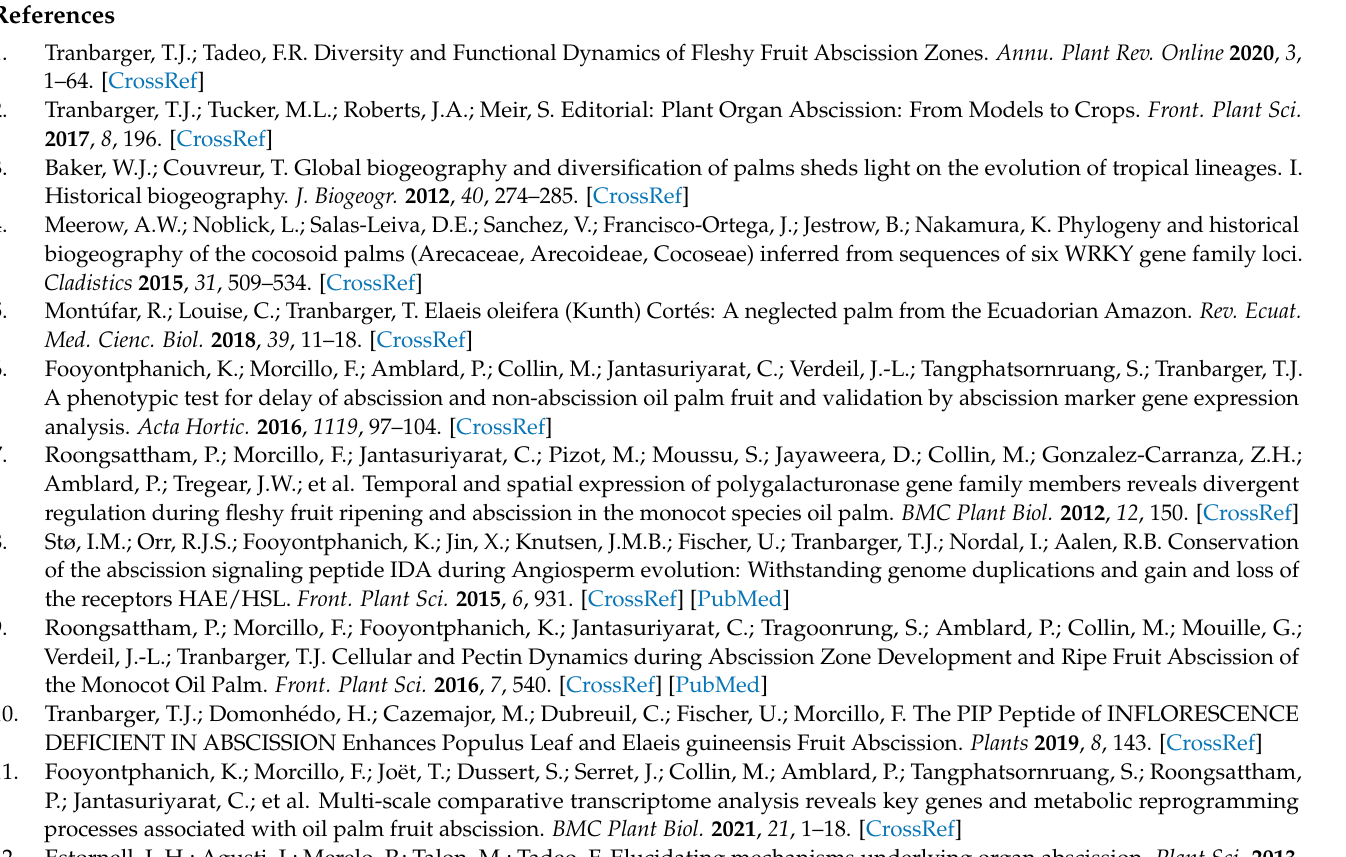
Table S3: 139 DEGs (UP and